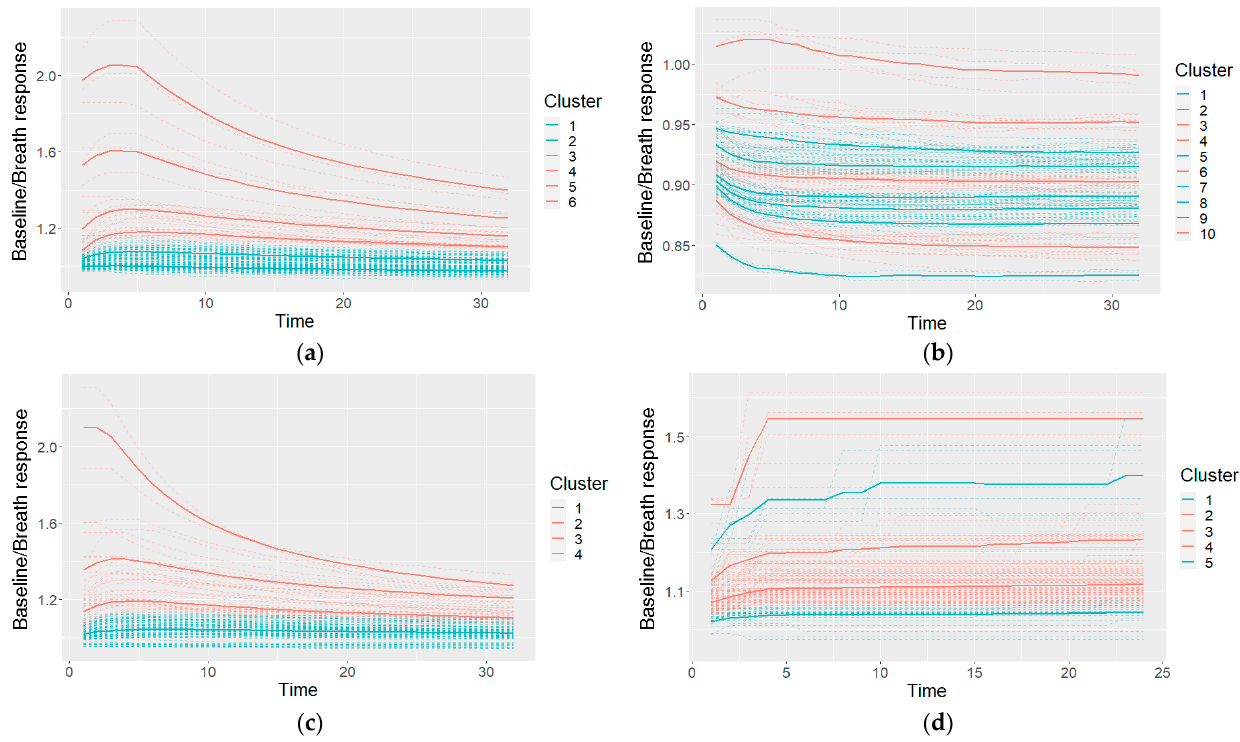
Figure 9. An example of the characteristic shapes used in a Naïve Bayes model: a taxonomy for GNP sensor responses cut at six clusters ( a ), taxonomies of two other GNP sensors cut at 10 and four clusters ( b , c ), and one MOXD sensor at five clusters ( d ); the dashed lines shows individual measurements, and the solid bold lines show the cluster-characteristic shapes.